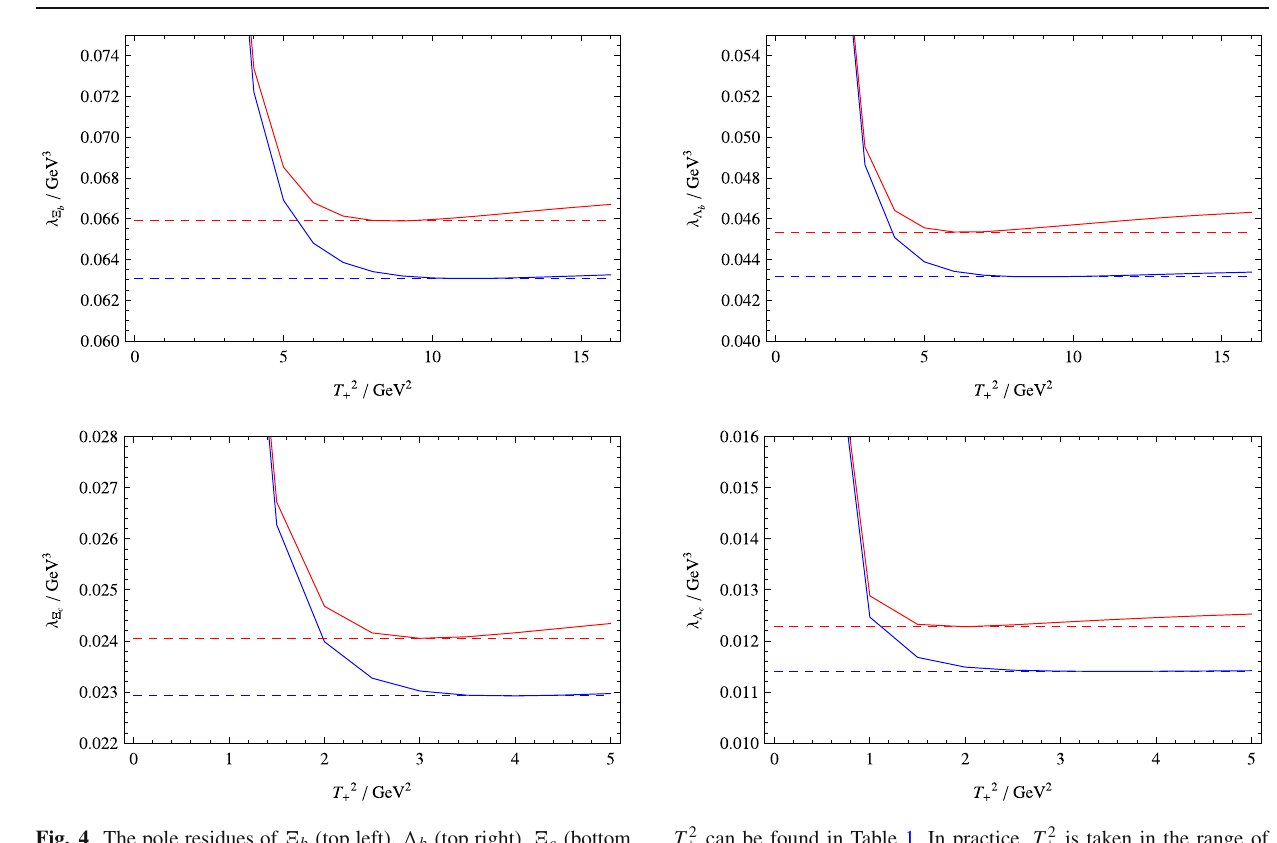
the values at suboptimal s + and T 2 + provide the error estimates. The results of bottom and charmed baryons are, respectively, obtained at the renormalization scale μ = m b and μ = m c ,